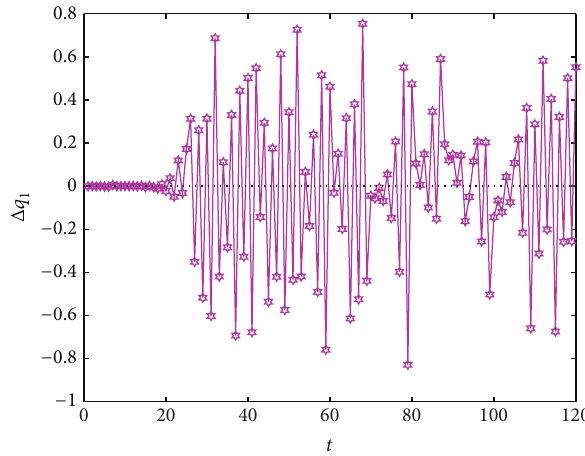
Figure 19: For 𝛼 1 = 2.05 , 𝛼 2 = 1.46 and 𝜃 = 0.5 , and the initial conditions which are (0.56, 0.92) and (0.561, 0.92), the difference with the change of time about the output 𝑞 1 .